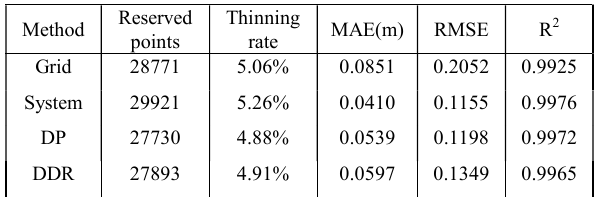
Table 1. Experimental results of the first group